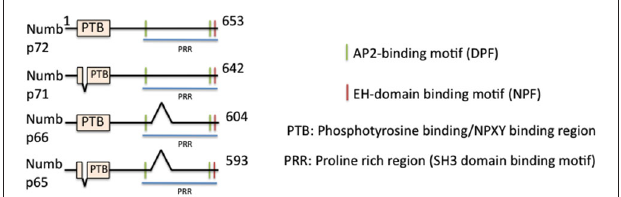
FIGURE 1 | Domain structure of numb and its isoforms . The domain structure of full length numb (p72) and three splice isoforms is depicted. Binding regions are indicated by color